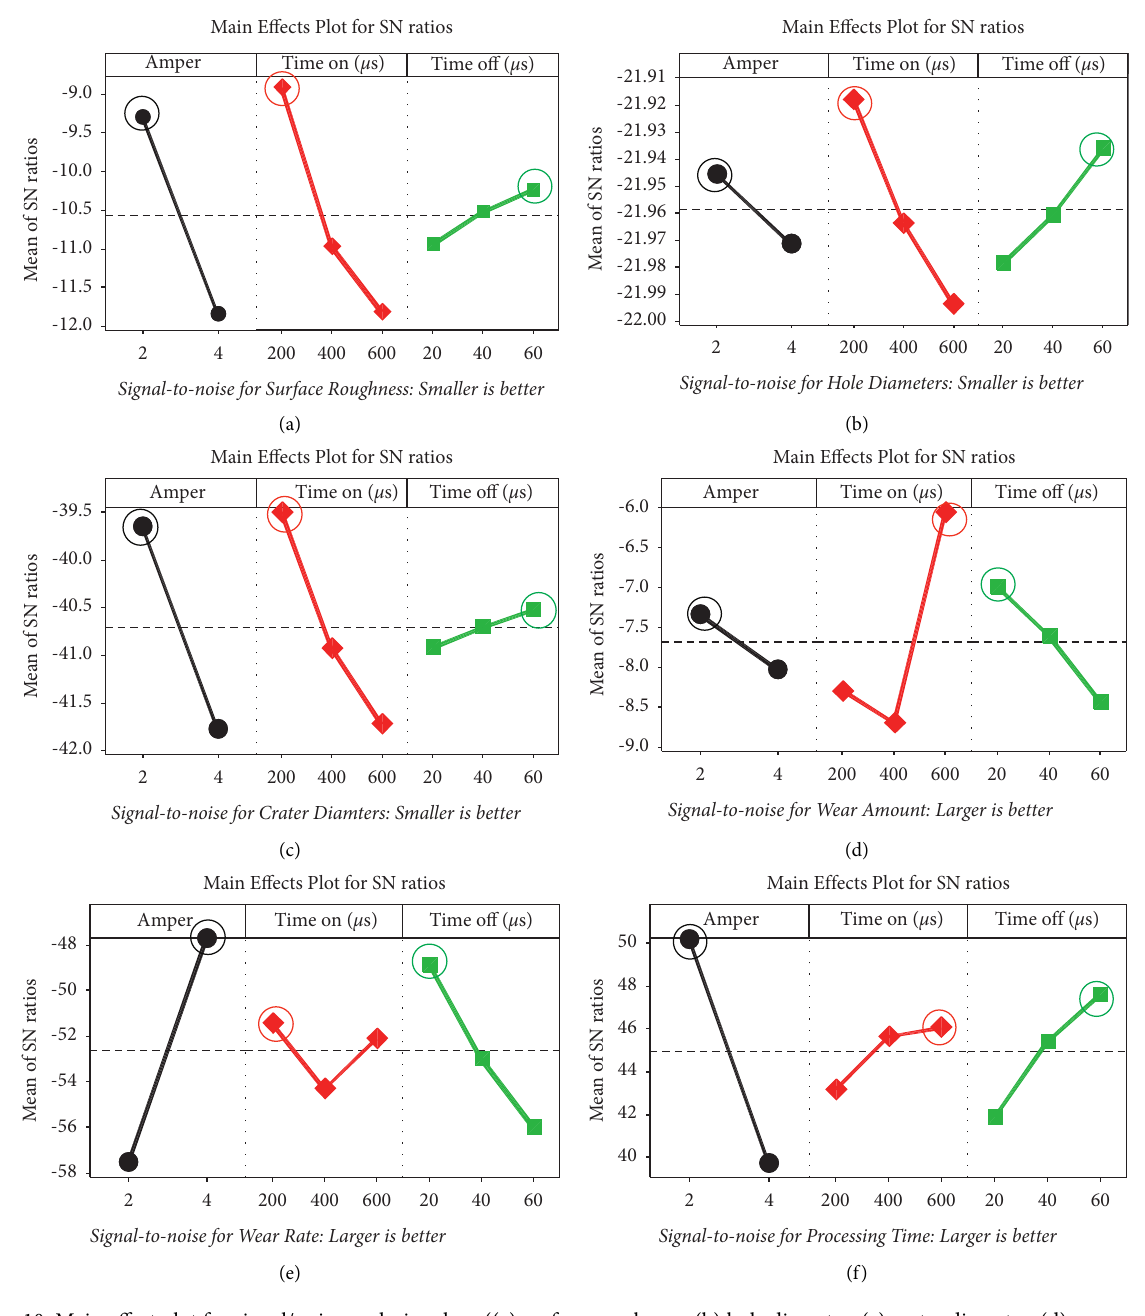
Figure 10: Main effect plot for signal/noise analysis values ((a) surface roughness, (b) hole diameter, (c) crater diameter, (d) wear amount, (e) wear rate, and (f) processing